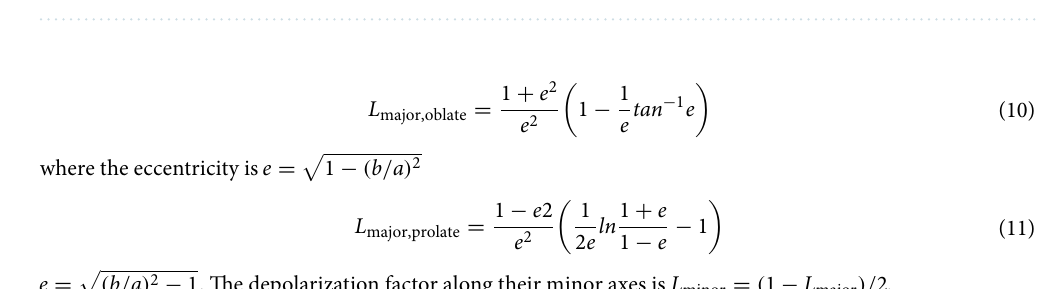
Table 1. Key parameters value of gold and